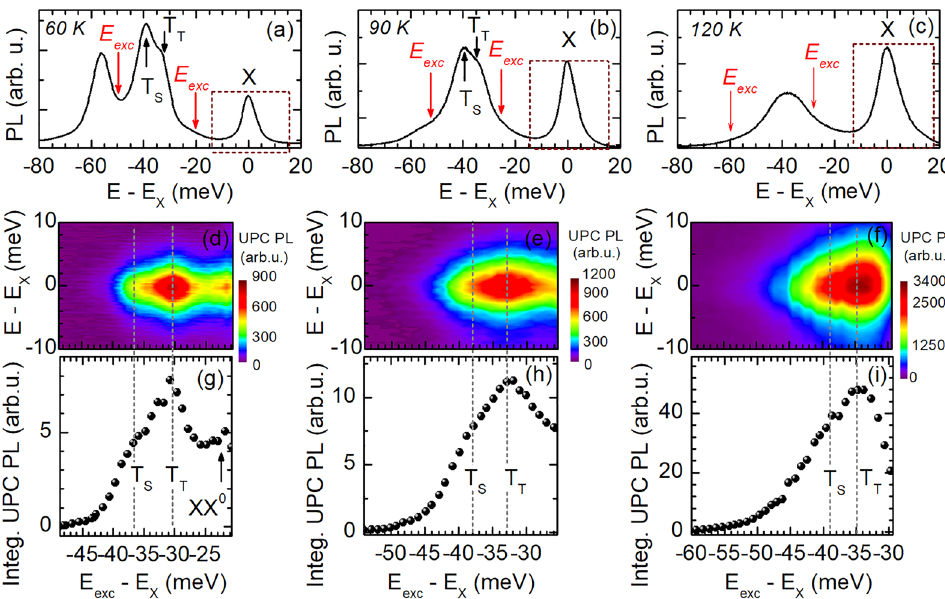
Figure 4. PL spectra of the hBN/WS 2 /hBN monolayer measured at ( a ) 60 K, ( b ) 90 K, and ( c ) 120 K. ( d – f ) UPC PL spectra for varying energy gain (cid:31) E taken at 60 K, 90 K, and 120 K, respectively. ( g – i ) Integrated UPC PL of X as function of (cid:31) E recorded at 60 K, 90 K, and 120 K, respectively.